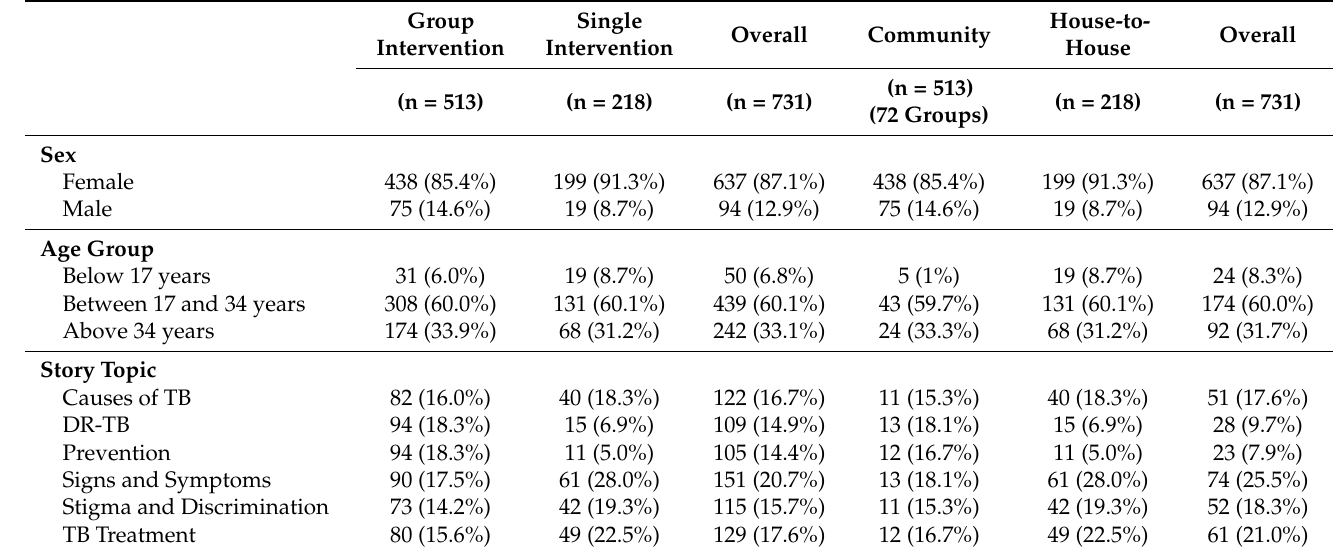
Table 1. Participant characteristics of the storyteller and TB ACF intervention by